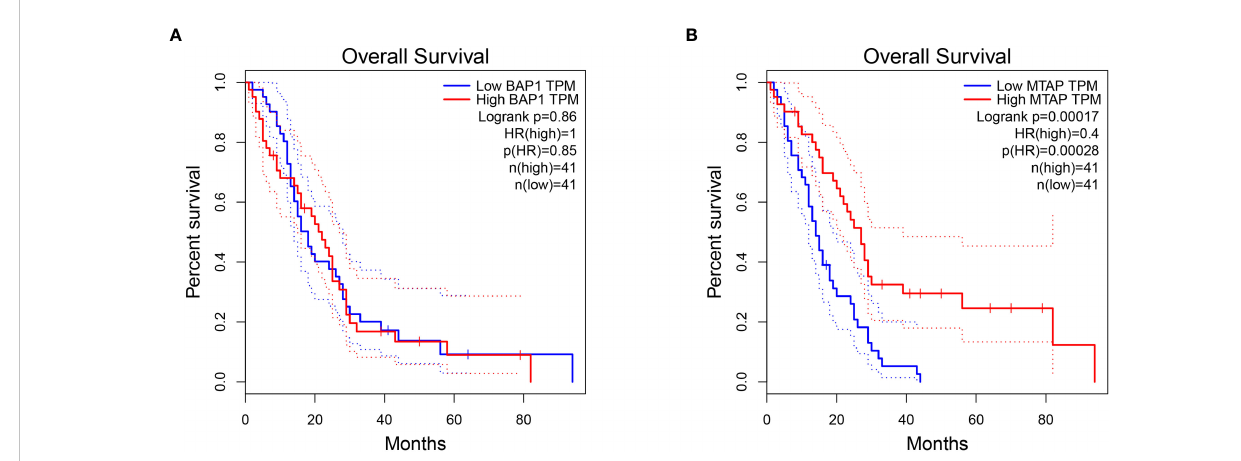
FIGURE 5 Overall prognostic analysis of BAP1 (A) gene and MTAP (B) gene in mesothelioma.